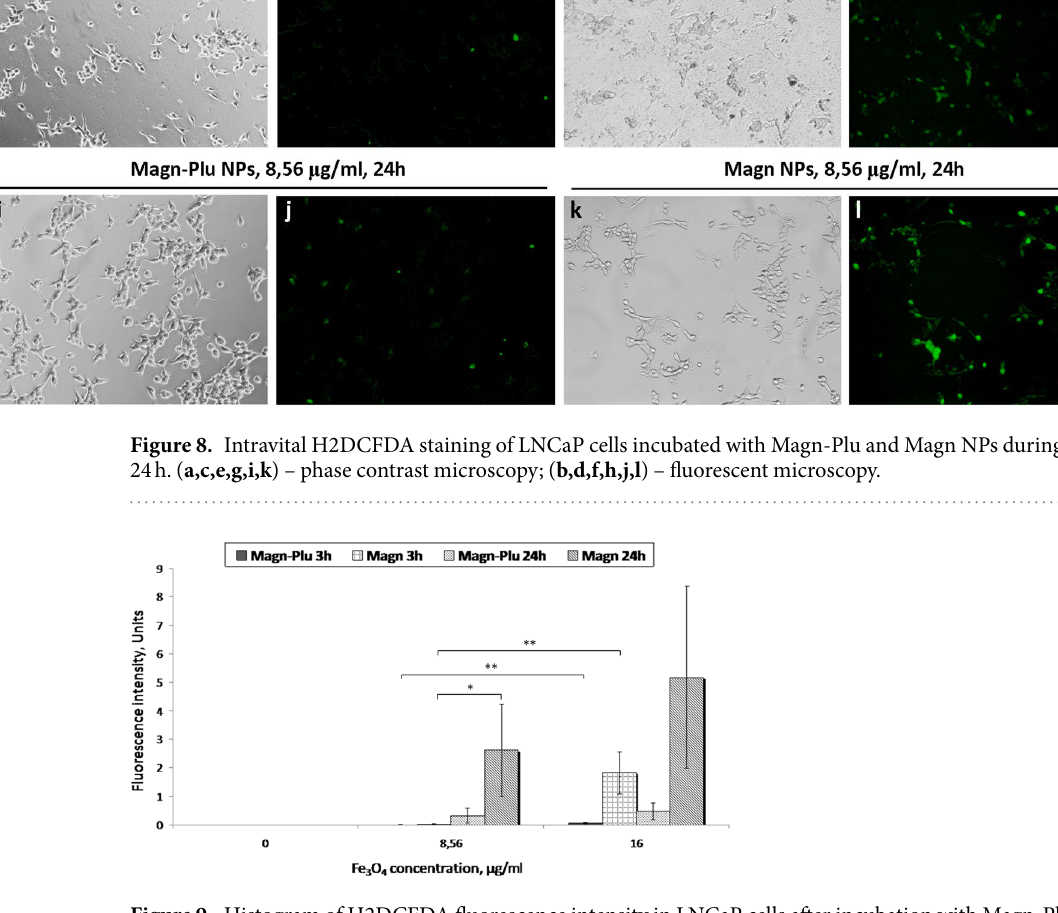
Figure 9. Histogram of H2DCFDA fluorescence intensity in LNCaP cells after incubation with Magn-Plu and Magn NPs for 3 h and 24 h. Results are shown as means ± SD. ** P < 0.01, * P < 0.05 (one-way